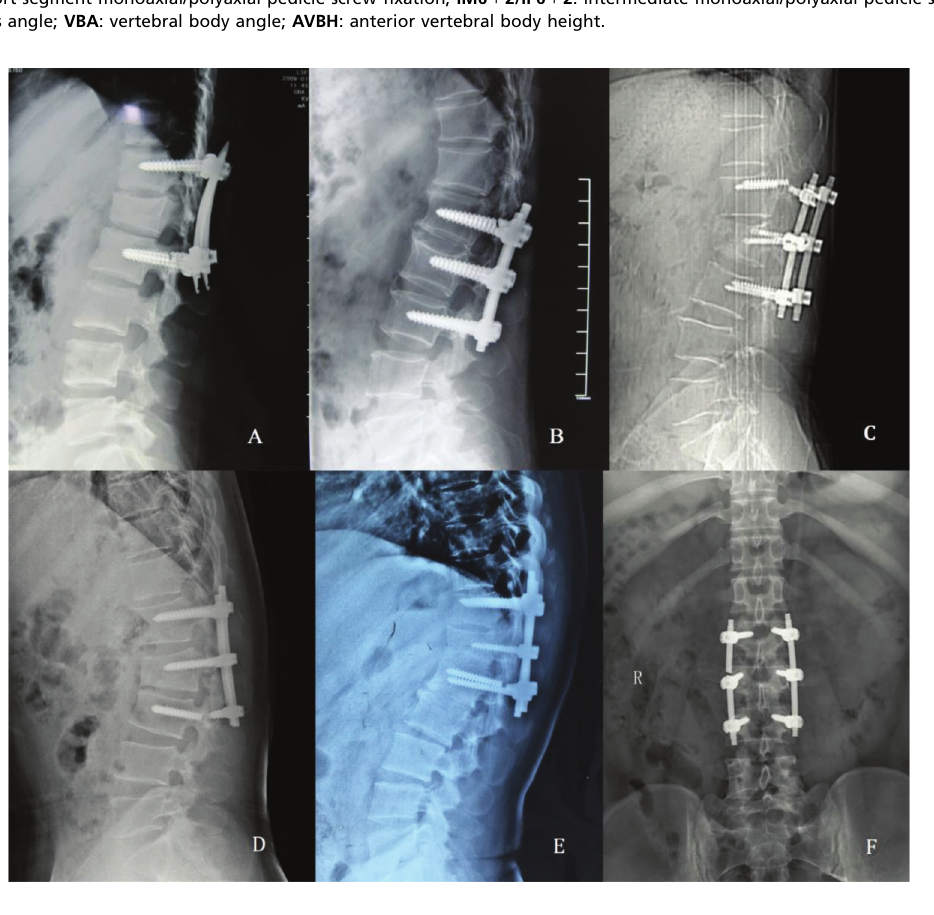
Figure 5 - Illustrative cases presented with pedicle screw and rod breakage. A. Pedicle screw breakage occurred 14 months after surgery in a 14-year-old girl with an L1 fracture. B. Pedicle screw breakage occurred 10 months after surgery in a 47-year-old man with an L2 fracture. C. Pedicle screw breakage occurred 18 months after surgery in a 39-year-old woman with a T12 fracture. D. Pedicle screw breakage occurred 8 months after surgery in a 35-year-old man with an L2 fracture. E. Pedicle screw breakage occurred 12 months after surgery in a 45-year-old man with a T12 fracture. F. Rod breakage occurred 24 months after surgery in a 27-year-old man with an L3 segment than MPSF models. Fracture-level fixation could The use of additional intermediate monoaxial pedicle significantly correct kyphosis and reduce correction loss, and screws may result in a stiffer construct and reduced VMS of ASD was less likely to occur in the IP6 + 2 group. Our results the pedicle screws than in SPSF models. In comparison, use provided a theoretical basis for the treatment of spinal of additional intermediate polyaxial pedicle screws may fractures using minimally invasive intermediate polyaxial result in a stiffer construct than the normal spine model and pedicle screw fixation. lower VMS of the pedicle screws and IDPs of the adjacent